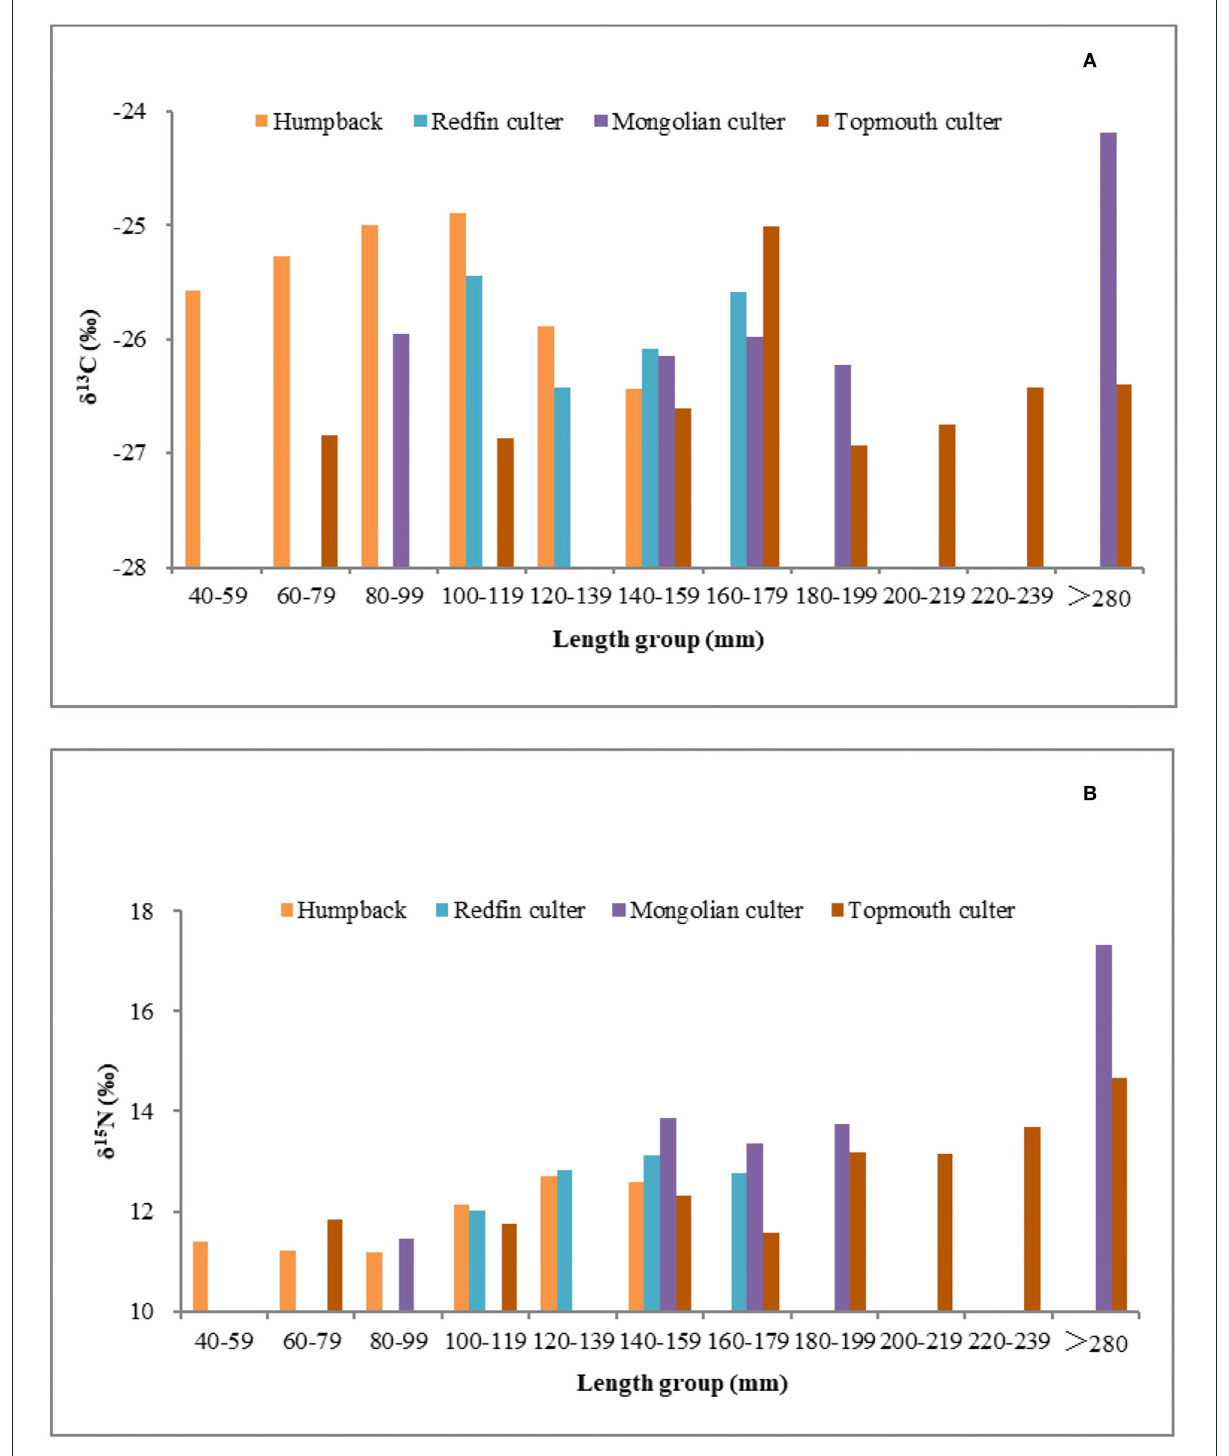
FIGURE5 Relationships between δ 13 C (A) and δ 15 N (B) values and standard lengths of humpback, redfin culter, Mongolian culter, and topmouth culter.